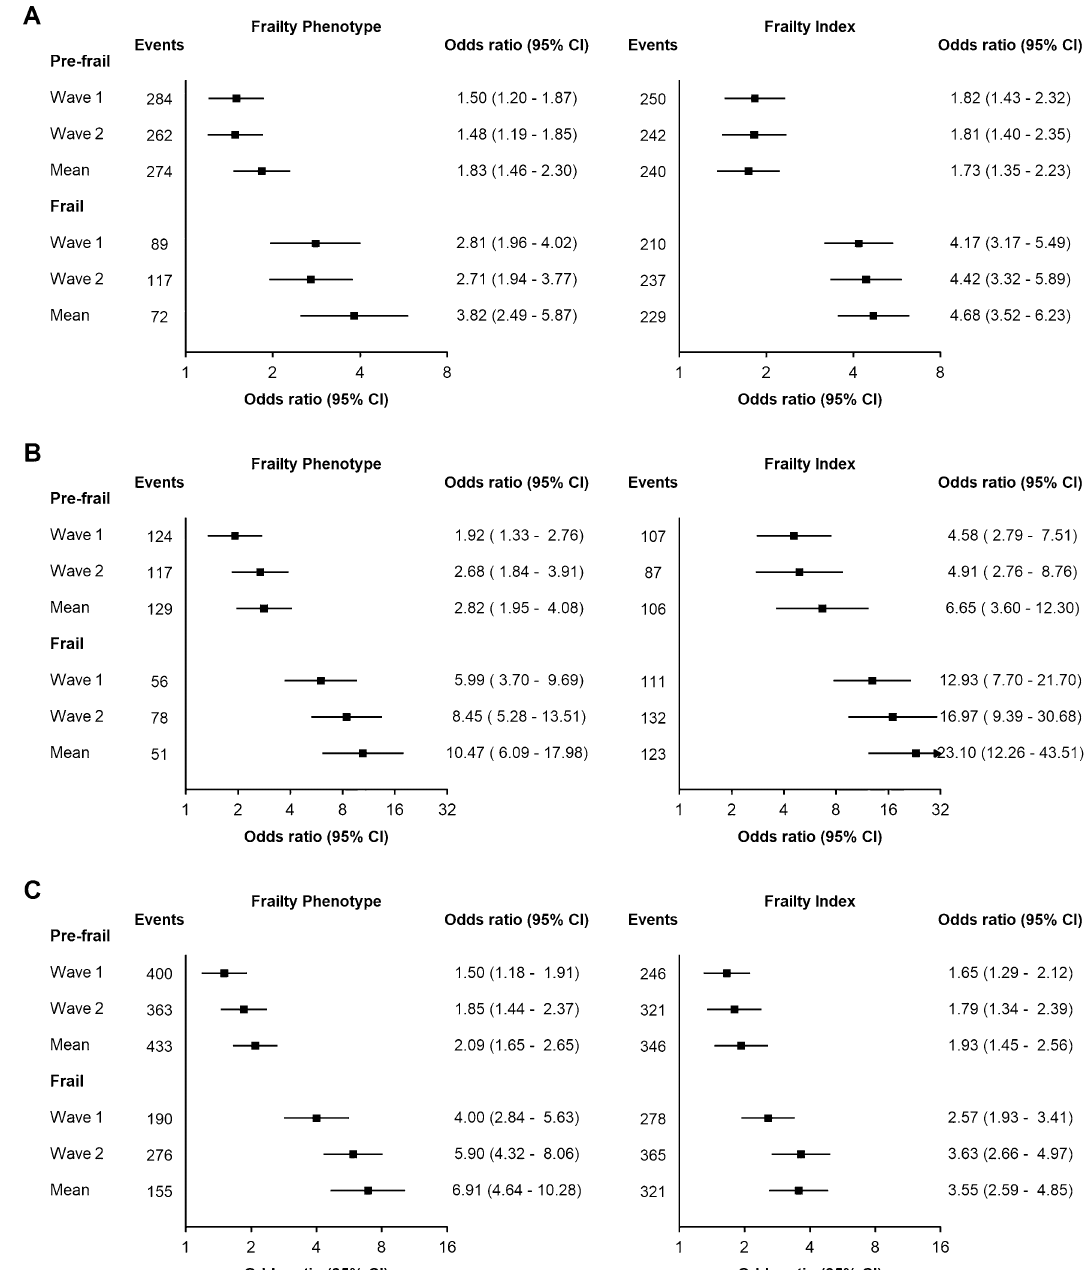
Figure 2. Associations of frailty phenotype and frailty index with recurrent falls ( A ) and overnight hospital stay ( B ) and all-cause mortality ( C ). Odds ratios (OR) were adjusted for age, sex, education level, social class, marital status, smoking status, and alcohol drinking frequency at baseline. Reference level was non-frail group for each frailty definition. Recurrent outcomes were defined as experiencing a disease outcome at Waves 1 and